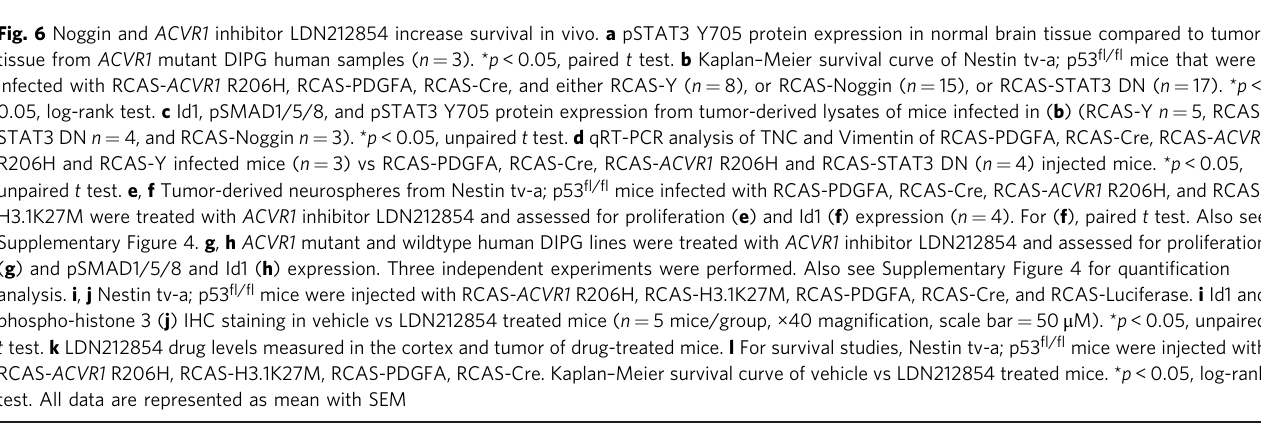
H3.1K27M) and DIPG007 ( ACVR1 R206H; H3.3K27M) were